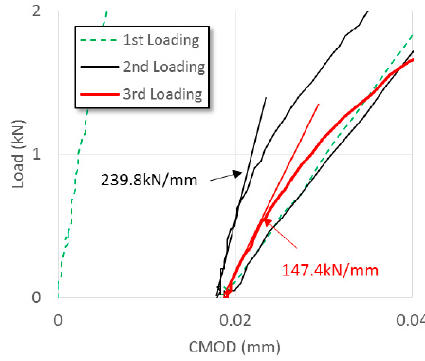
Figure 2. Typical Load-CMOD (crack mouth opening displacement) curves (Case: 7-28-A).